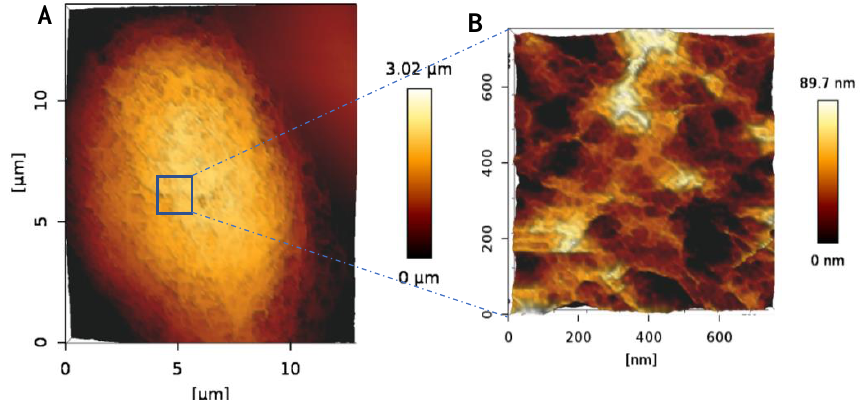
Figure 4. ( A ) AFM 3D height image of a bACh isolated from SA – GEL – GA taken under PBS showing the circular morphology of the cell. ( B ) 3D closeup scan area taken on top of the imaged cell showing the nanostructural details of the cell surface more closely.